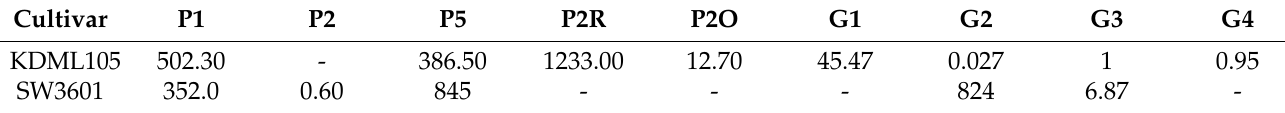
Table 2. Genotype coefficient of Khao Dawk Mali 105 (KDML105) and short-season (SW3601) cultivars. Cultivar